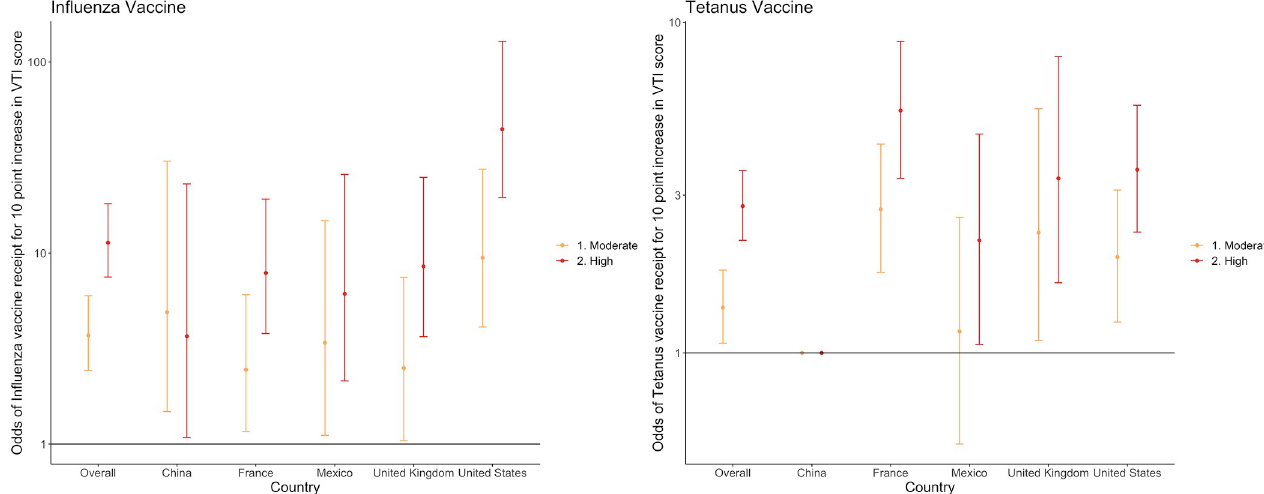
Fig 2. Odds of influenza and tetanus vaccine receipt by VTI score category overall and by country * reference group = low trust in vaccines.